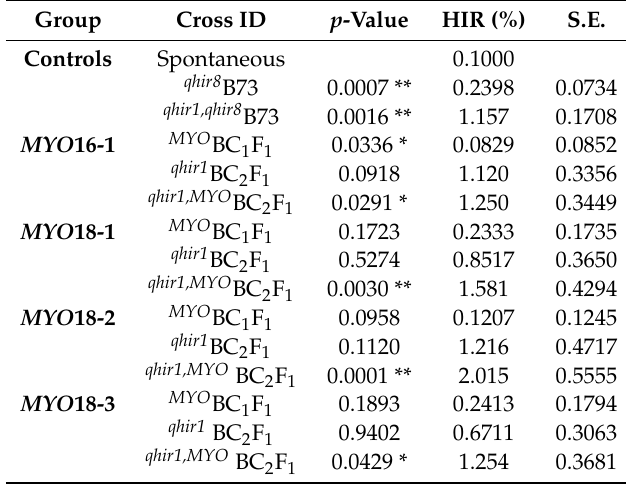
Table 2. Mean values and standard errors for HIR are reported along with the p -values, which indicate significance when compared to spontaneous HIR of 0.1% (* at the 0.05 level and ** at the 0.01